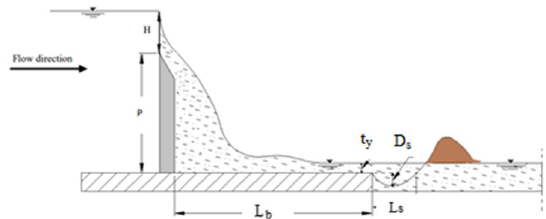
Fig. 1 Definition parameter of weir and